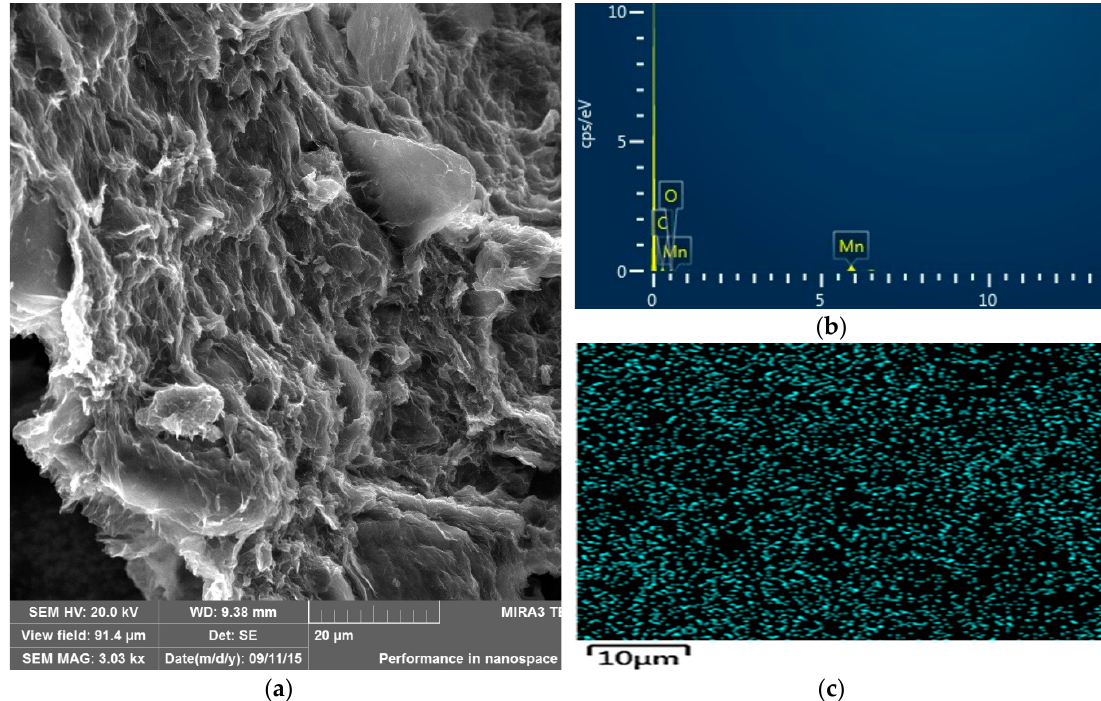
Figure 2. ( a ) SEM images of GO ‐ MnO 2 nanocomposite; ( b ) SEM ‐ EDS; ( c ) SEM ‐ maps of the manganese distribution on the GO ‐ MnO nanocomposite.